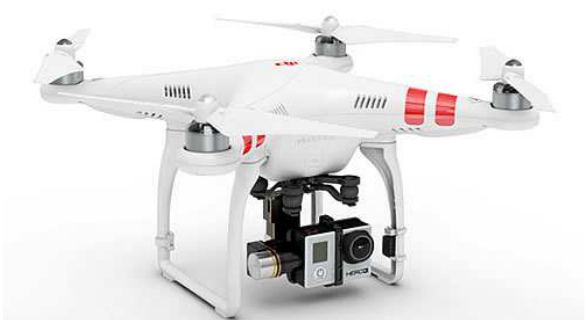
Figure 1: RPAS used for the photogrammetric survey